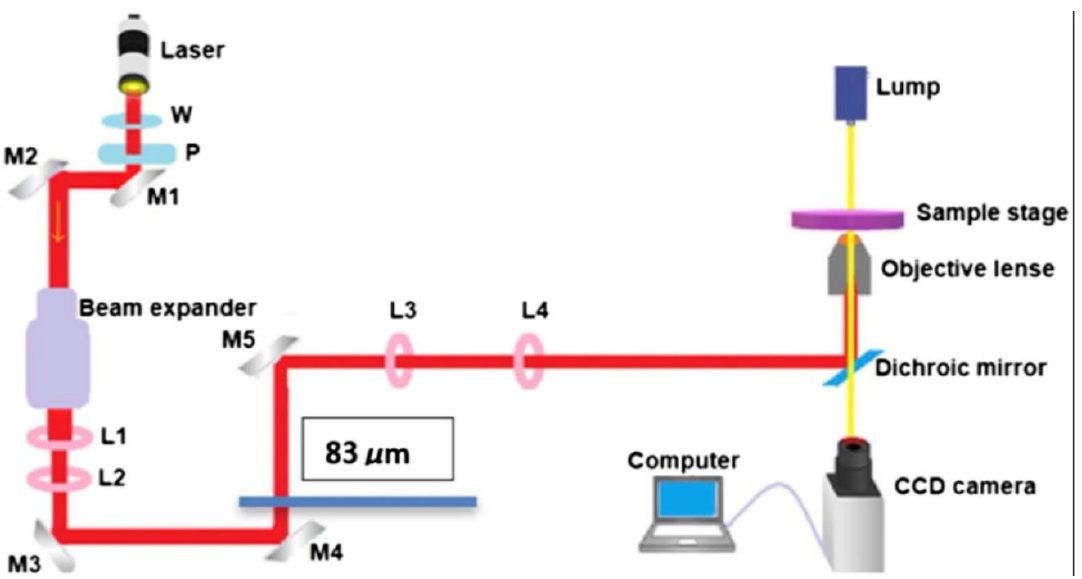
Figure 1. The experimental setup for the laser trap is shown in the diagram. It has a wavelength of 1064 nm and can output up to 8 W. Half-wave plates (W) and polarizers (P) control the output power. See Ref 21. for further detail.